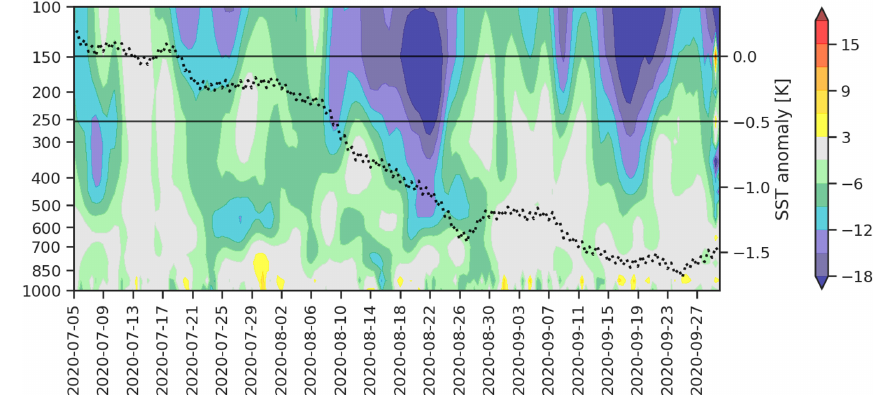
Figure 4. Relative differences in 48h forecast RMSE of the zonal-wind component (%) between EXP_A and CTRL (5 ◦ S–5 ◦ N, 90–160 ◦ W) as function of forecast time and pressure (hPa). The black dotted line is the sea surface temperature (SST) anomaly from the ERA5 reanalysis of 1985 to 2015.